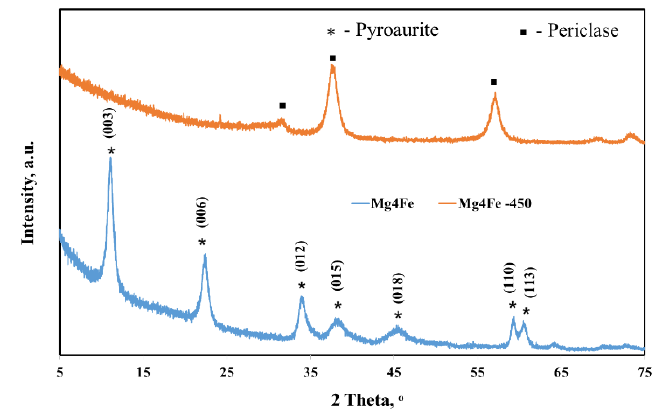
Figure 1. XRD pattern of the synthesized materials.